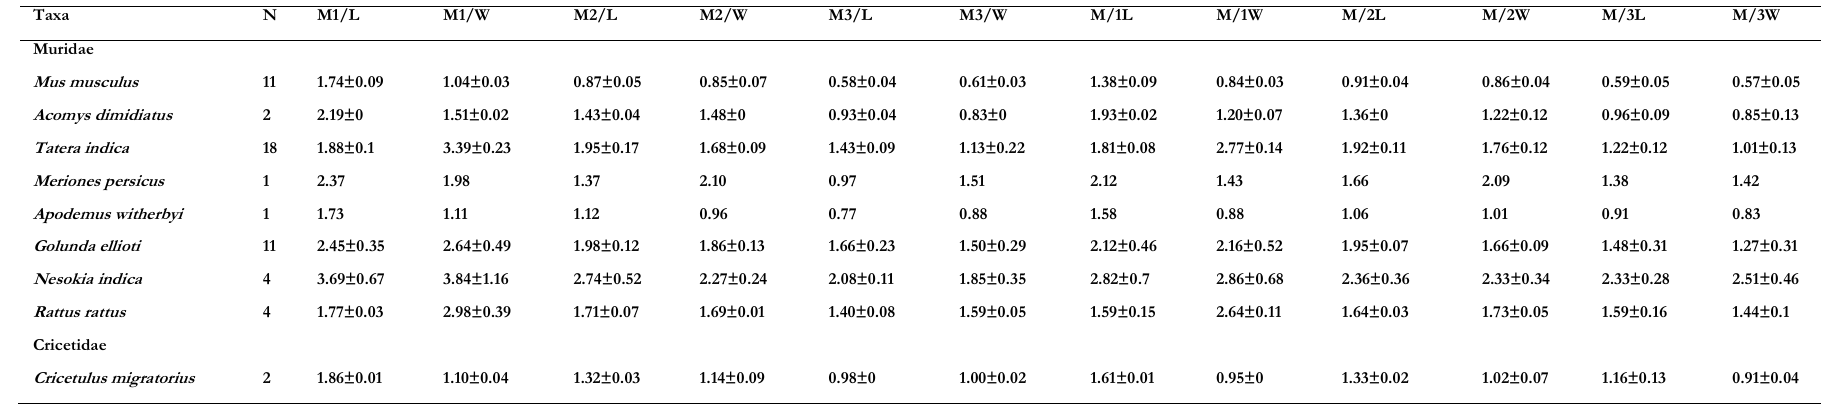
TABLE 4. Dental measurements (Mean ± SD, in mm) of species of rodents in Jiroft and Anbarabad